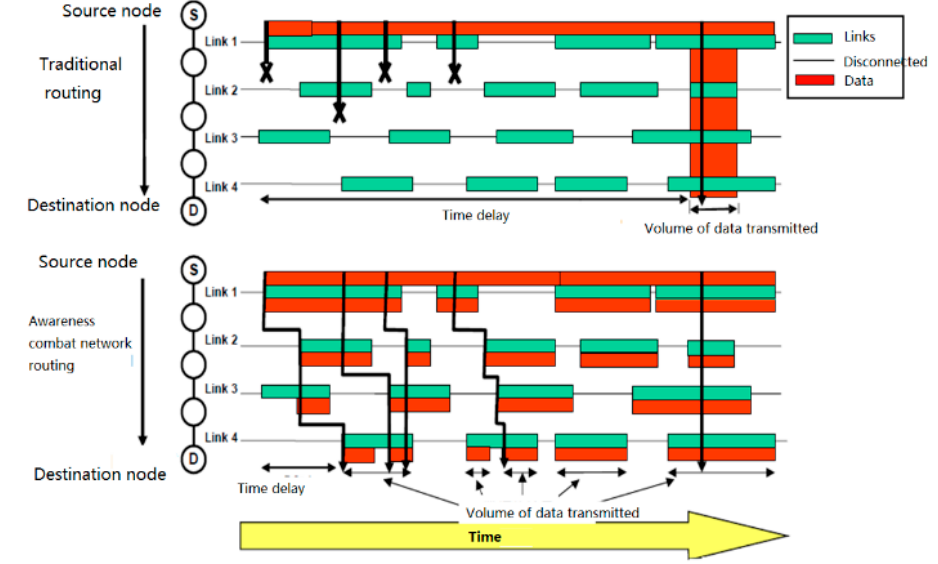
Figure 6. Data transmission diagram of awareness combat network routing (“flat” state).